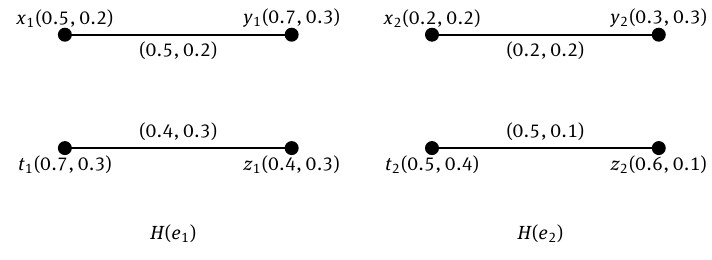
Figure 4: Interval-valued fuzzy soft graphs (cid:102) G 1 and (cid:102) G